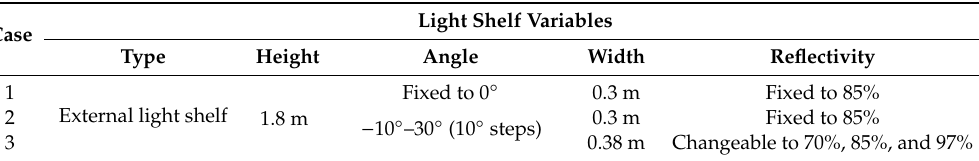
Table 5. Cases for performance